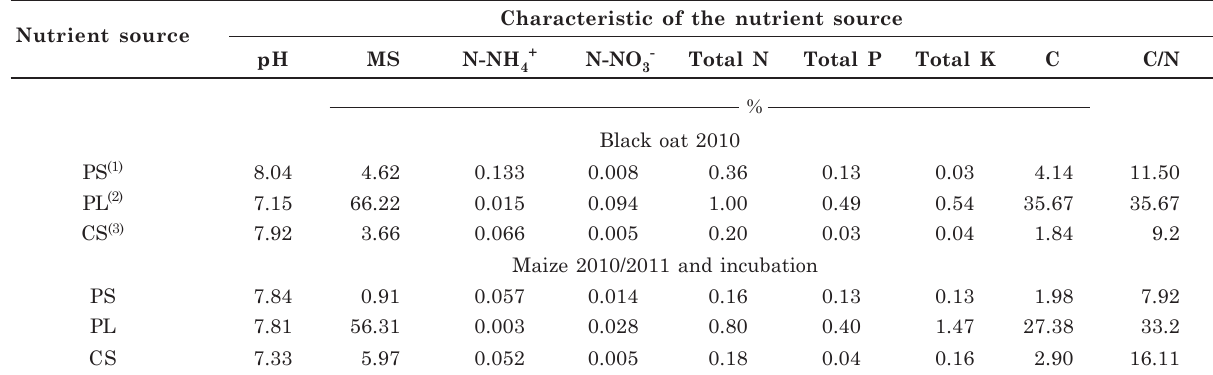
(1) Pig slurry; (2) Pig deep litter; (3) Cattle